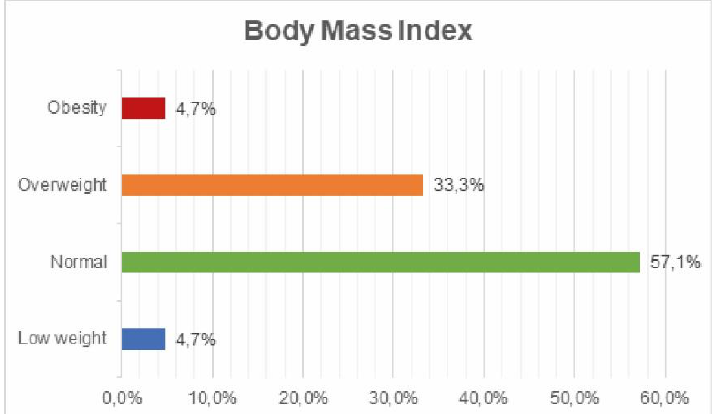
Figure 9. Body mass index value survey.